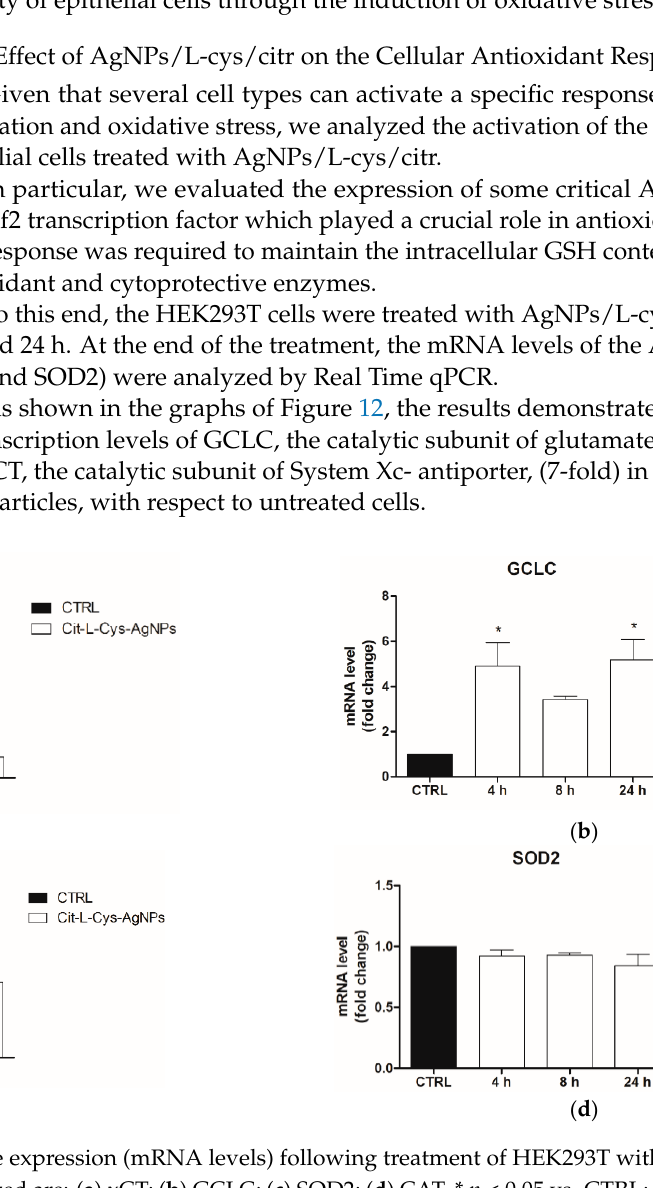
Figure 11. Effect of AgNPs/L-cys/citr on HEK293T cells counting. Number of live and dead cells after 24h from treatments with cit-L-cys-AgNPs (25-50-75-100 μ g/mL) and AgNPs/L-cys/citr (100 μ g/mL) + NAC (2mM). Live cells: * p < 0.05 vs. CTRL; *** p < 0.001 vs. CTRL; ^^^ p < 0.001 vs. 100 + NAC; ° p < 0.05 vs. 75 μ g/mL and 50 μ g/mL. Dead cells: *** p < 0.001 vs. CTRL; ^^^ p < 0.001 vs. 100 + NAC.